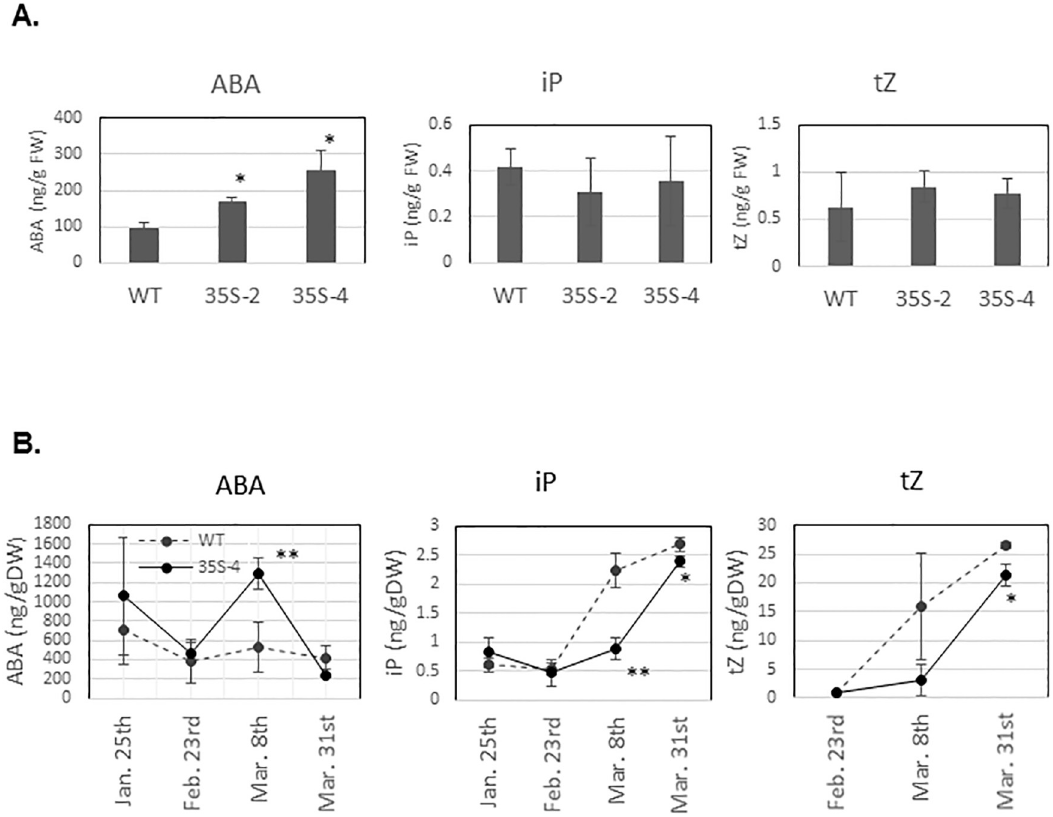
Fig 5. Abscisic acid and cytokinins (tZ and iP) contents in the terminal buds were higher and lower, respectively, in the dormancy-enhanced 35S : PmDAM6 apple plants than in the WT plants. Phytohormone contents in the terminal buds of 4-year- old plants collected on 20 February 2015 (A), and of 6-year-old plants collected on 25 January, 23 February, and 8 and 31 March 2017 (B). Values are presented as the means of three replicates. Bars indicate standard errors. Significant differences in the phytohormone contents between WT and 35S : PmDAM6 apple plants are indicated with �� and � at P < 0.01 and P < 0.05 (Student’s t -test),